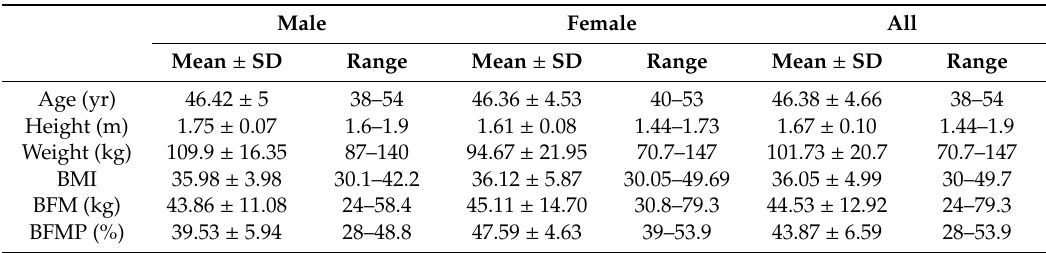
Table 1. Participants’